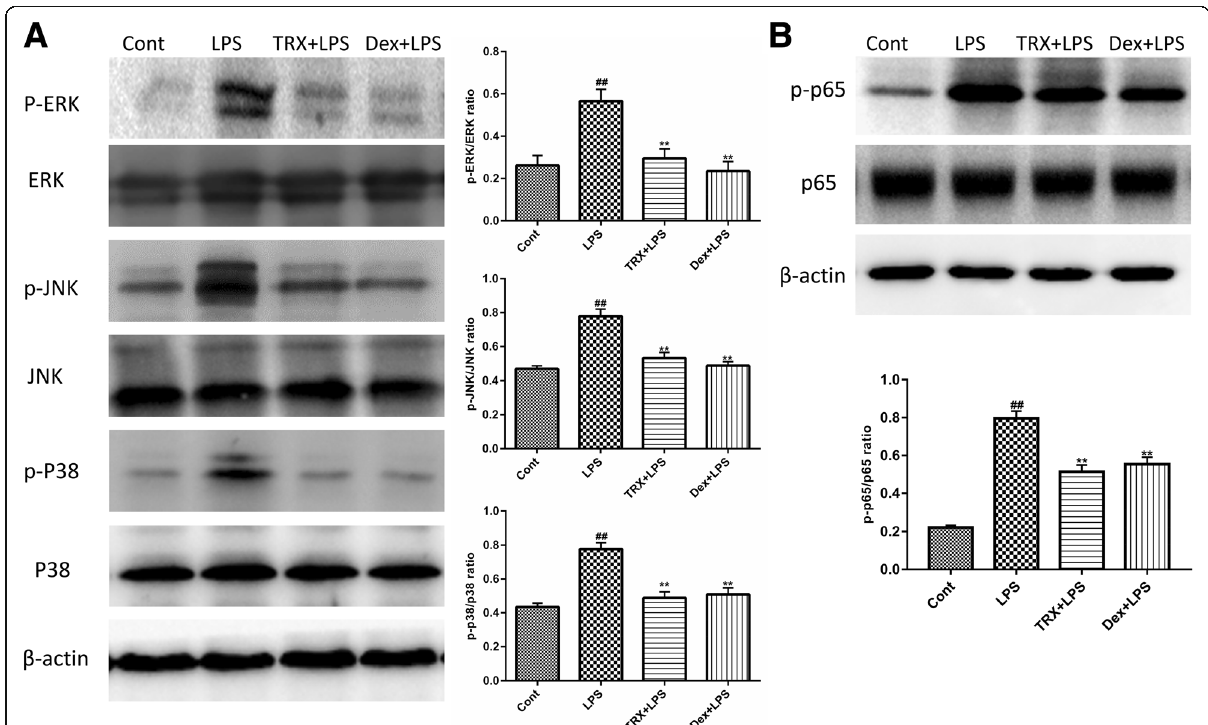
Fig. 7 The effects of TRX on MAPK and NF- Κ b pathway activation in the lung tissues from mice with LPS-induced ALI. The activation of MAPKs and NF- Κ b were detected using Western blotting. Means ± SEM values of p-ERK/ERK, p-JNK/JNK, p-p38/p38 and p-p65/p65 ratios via quantitative densitometry from different groups. The assay shown is representative of three experiments with similar results. The data presented are the mean ± SEM ( n = 5). # P < 0.05, ## P < 0.01 compared with control group, * P < 0.05, ** P < 0.01 compared with LPS group (one-way